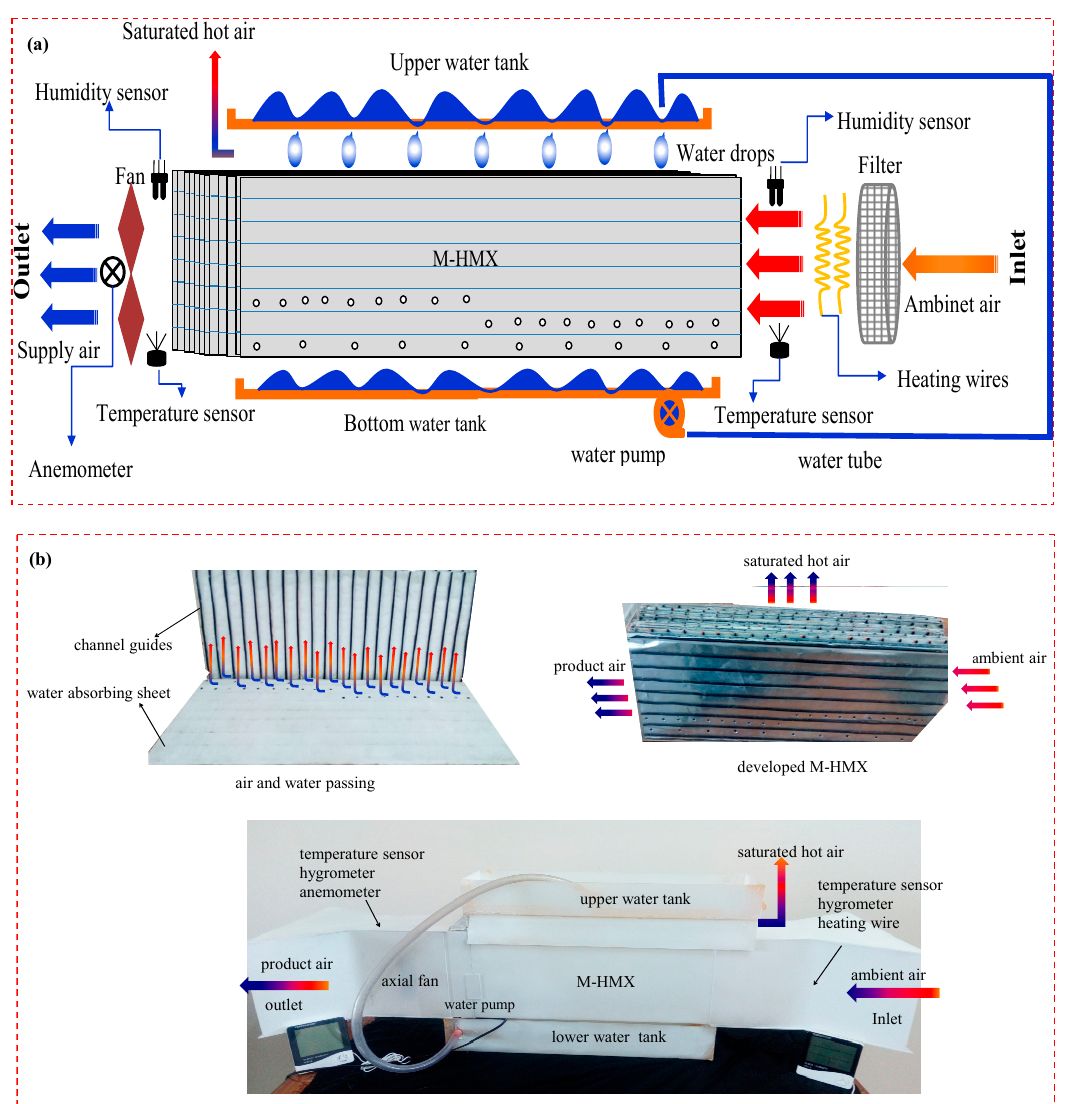
Figure 3. Schematic diagrams of M-cycle evaporative cooling system: ( a ) schematic diagram, and ( b ) pictorial representation of the experimental apparatus.